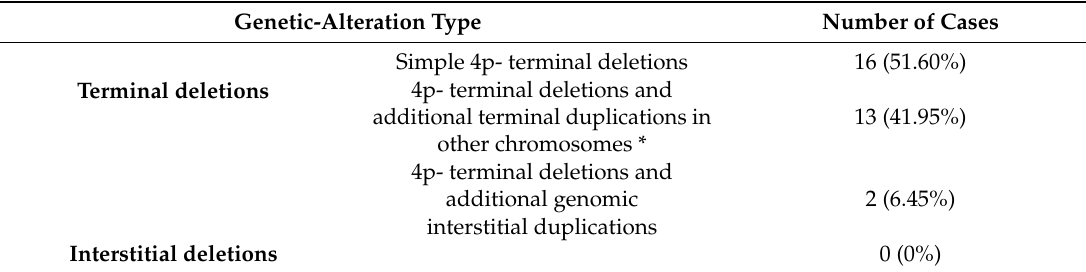
Table 3. Genetic analysis of study-group patients with Wolf-Hirschhorn syndrome ( n =